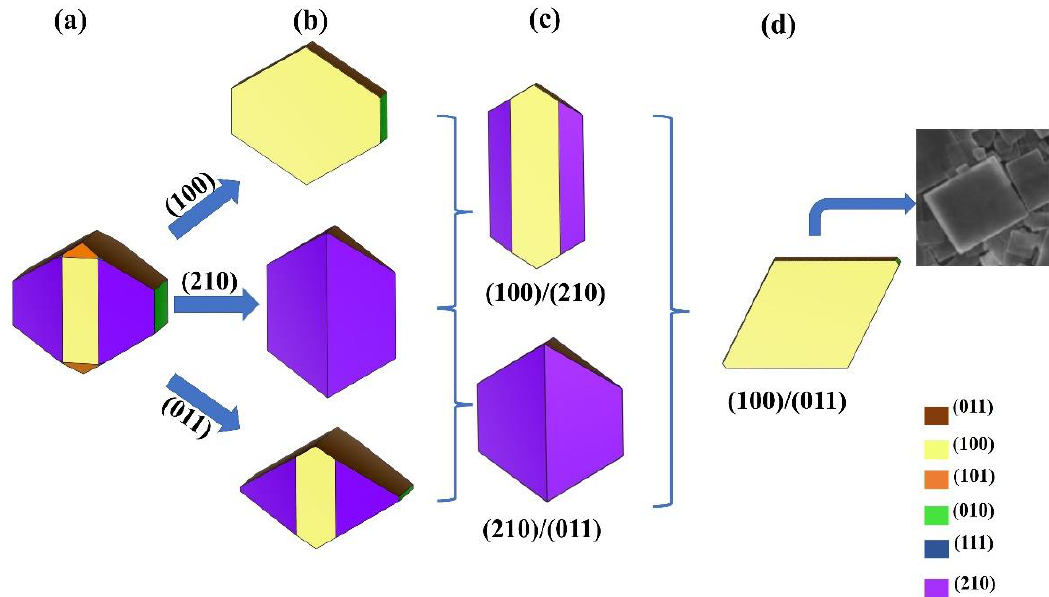
Figure 6. Different morphologies of β -Li 3 PS 4 nanocrystals obtained by varying the relative stability of the various surfaces. Panel ( a ): the ideal nanocrystal based on our results. The blue arrows indicate the stabilization of the (100), (011), and (210) surfaces while the curly brackets indicate the simultaneous stabilization of the surfaces (100)/(011), (210)/(100), and (100)/(011). The resulting nanostructures are in the ( b – d ) panels, respectively. In the ( d ) panel, the SEM of β -Li 3 PS 4 obtained by Hood and co-authors is also reported [31].